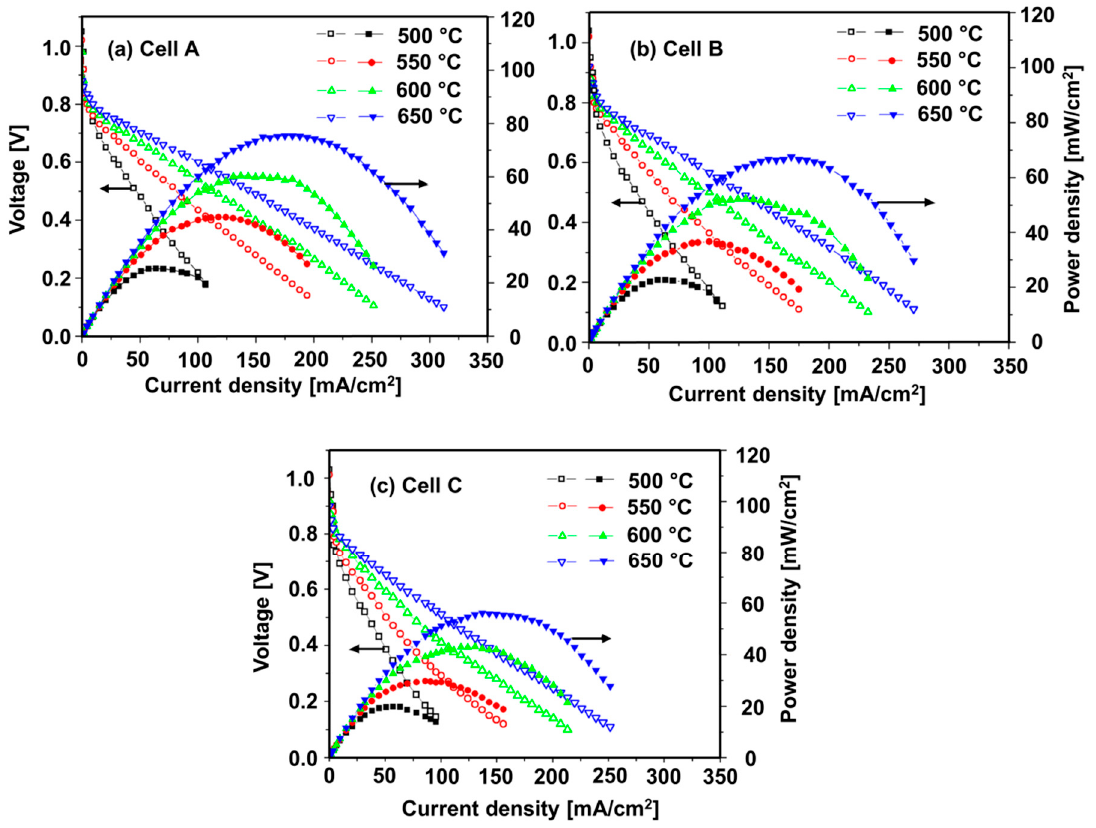
◦ C, 550 ◦ C, 600 ◦ C, and 650 ◦ C: ( a ) cells A, ( b ) B, and ( c ) Figure 5. Performance of single cell at 500 °C, 550 °C, 600 °C, and 650 °C: ( a ) cells A, ( b ) B, and ( c ) C. Figure 5. Performance of single cell at 500